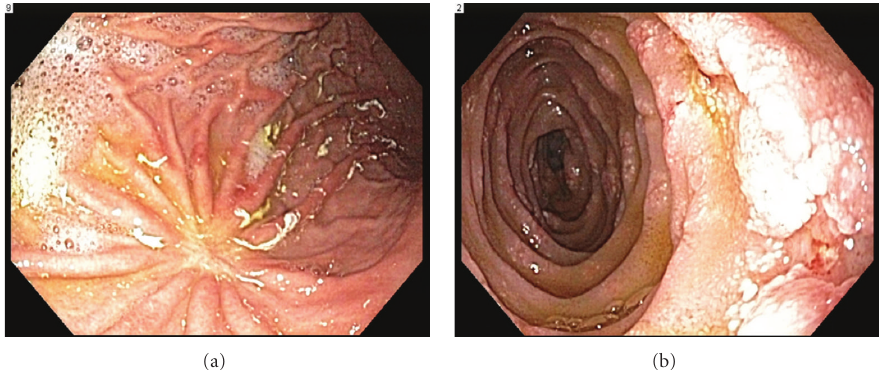
Figure 1: (a) Endoscopic view of the greater curvature of the stomach showing a well-healed scar from prior CMV gastric ulcer. (b) Endo- scopic view of the duodenum showing di ff use